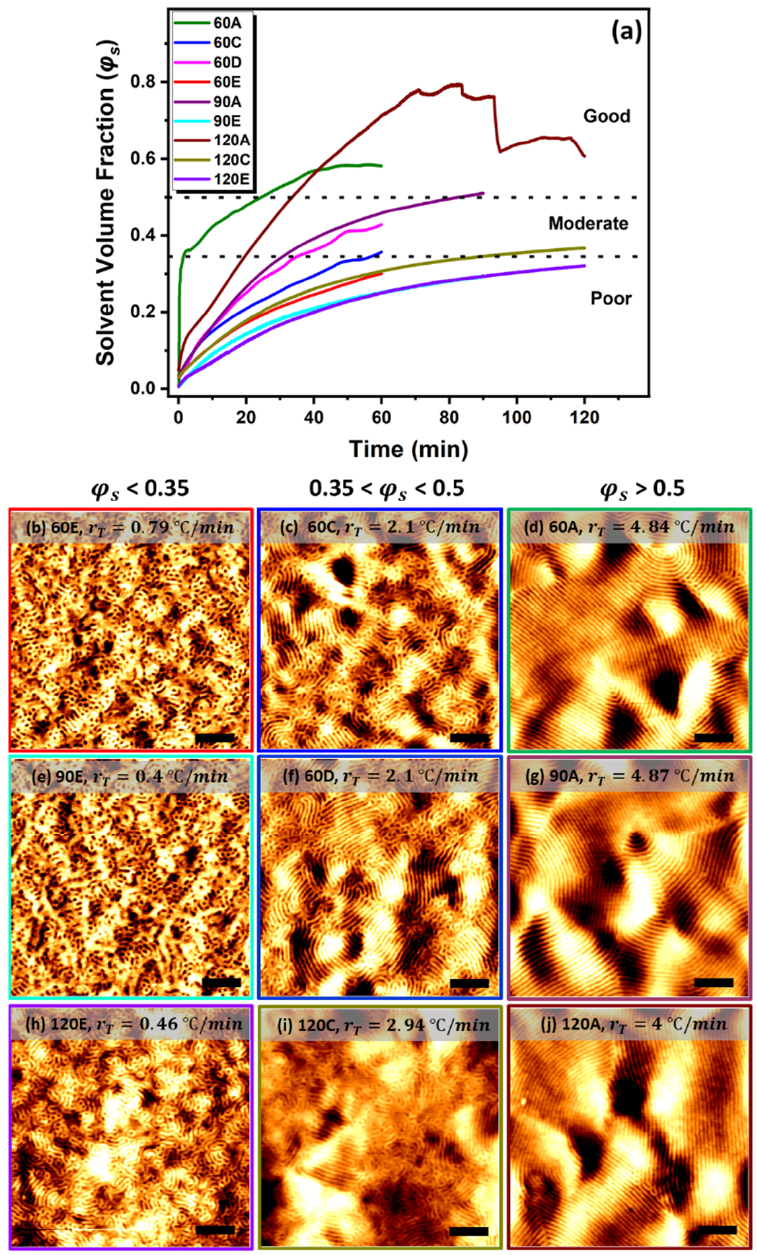
Figure 4. The effect of heating ramp on solvent uptake. ( a ) Evolution of solvent volume fraction ( ϕ s ) in the swollen films during slow and fast heating regimes, and various annealing intervals. Corresponding AFM images show how the solvent volume fraction imposes different degrees of the lateral order in PS- b -PLA film (poor/moderate/good): ( b , e , h ) showing poor phase separation ( ϕ s < 0.35 ) ; ( c , f , i ) showing moderate phase separation ( 0.35 < ϕ s < 0.5 ) ; ( d , g , j ) showing good translational order ( ϕ s ≥ 0.5 ) . The AFM scale bars are 300